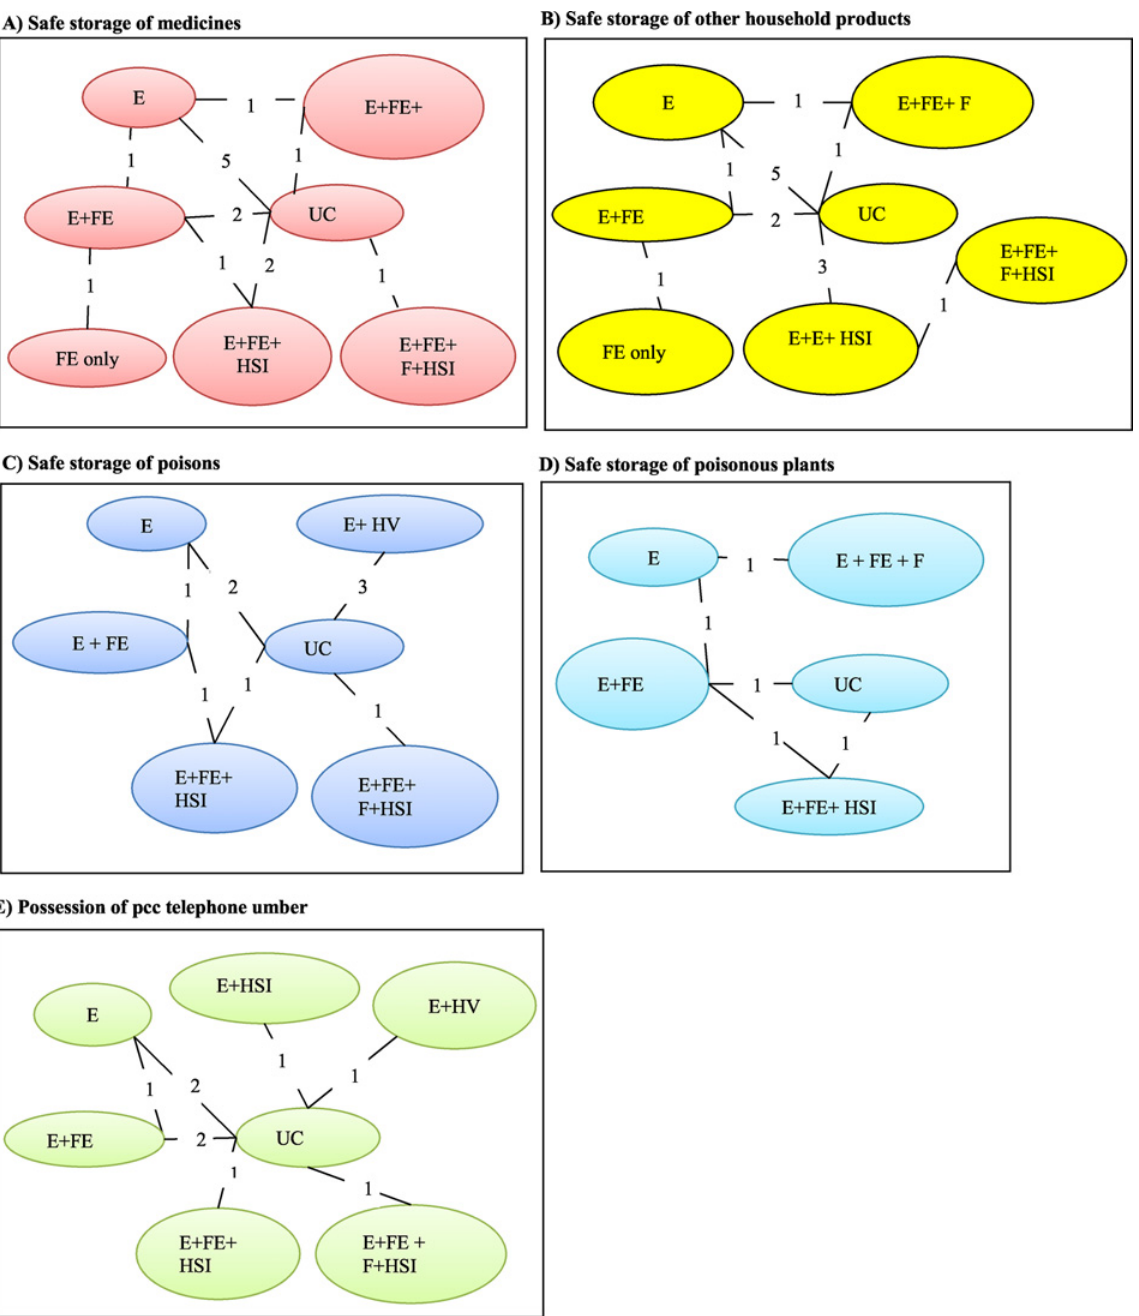
Fig 2. Network Diagrams of interventions to increase safety practices to prevent poisonings in pre-school children in the home. PCC = poison control centre telephone number. Nodes/oval circles represent an intervention (E = education, F = Fitting, FE = low cost/free equipment, HSI = Home safety inspection, HV = Home visit). For example E+FE+HSI = Education + low cost/free equipment + home visit intervention. The lines connecting any two nodes represent the pairwise comparison. The numbers on each line represent the total number of studies and the number of non-RCTs (in brackets) contributing to each pairwise